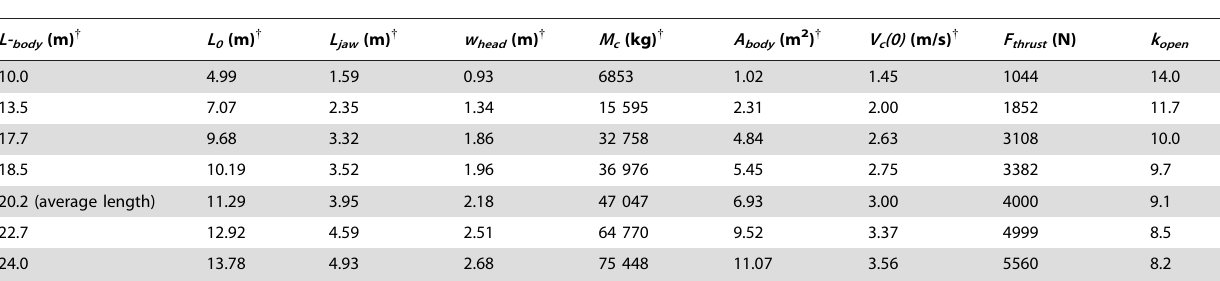
Table 2. BLF3 simulation inputs – fin